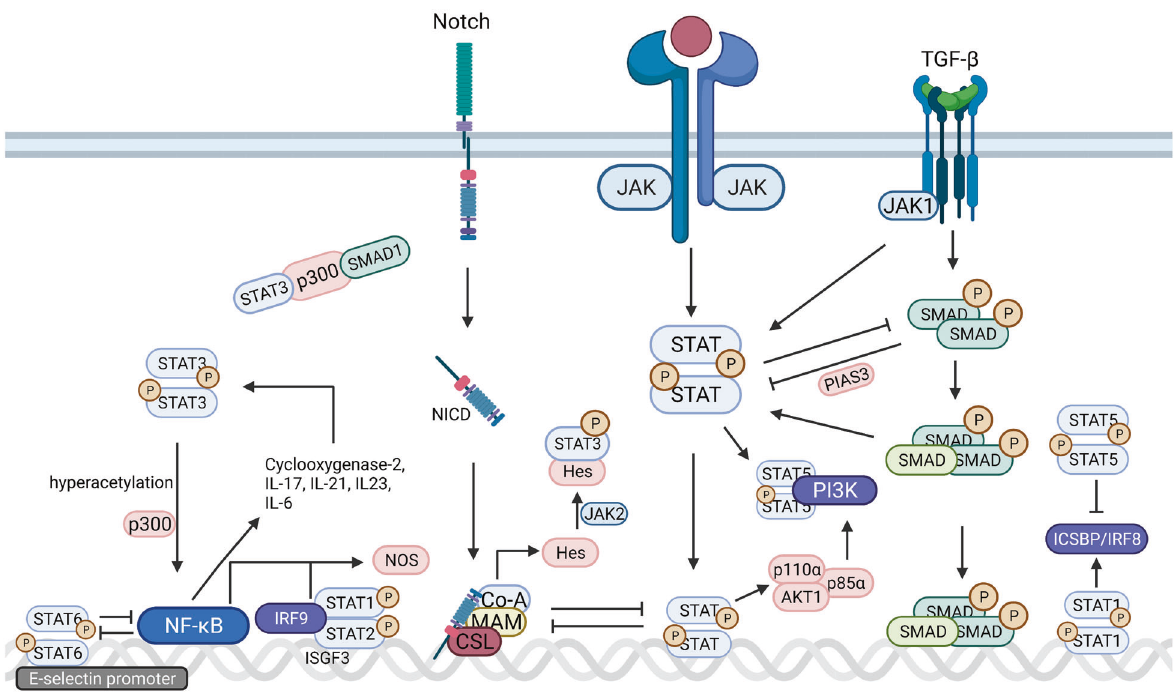
Fig. 4 Signaling cross-talk between JAK/STAT and other pathways. (1) STAT3-p300- SMAD1 forms a complex to induce astrocyte differentiation; (2) JAK1 binds to TGF β RI and activates STAT3; (3) TGF- β also activates STAT3 via SMAD-dependent manner. (4) STAT3 inhibits SMAD3 – SMAD4 complex formation and suppress SMAD3-DNA binding; (5) SMAD3 inhibits STAT3 activation via recruiting PIAS3 to STAT3; (6) TGF- β blocks IL-12 mediated JAK2 and TYK2 tyrosine phosphorylation; (7) Notch signaling suppresses JAK/STAT activation by interfering with STAT translocation to the DNA domain, and signals of JAK/STAT inhibited Notch signaling conversely. (8) Hes proteins directly bind to STAT3 and induce phosphorylation by recruiting JAK2; (9) STAT5 direct interacts with PI3K; (10) STAT5 upregulates the expression of p85 α ( Pik3r1 ), p110 α (Pik3ca) , and AKT1 ; (11) STAT3 drives the hyperacetylation of RelA via interacting with p300; (12) cyclooxygenase-2, IL-17, IL-21, and IL-23 encoded by NF- κ B activate STAT3; (13) NF- κ B preceded ISGF3 (a complex containing STAT1, STAT2, and IRF9 subunits) at the Nos2 promoter, thus regulating nitric oxide synthase expression; (14) IRF9-STAT1-STAT2 trimeric complex induce gene expression; (15) STAT1 regulates IRF8 synthesis; (16) STAT5 suppresses IRF8 activity; (17) STAT1 and IRF1 synergistic induce IFN γ -induced gene transcription; (18) IRF8 increases IFN γ -induced gene transcription mediated by STAT1 and IRF1. Created with